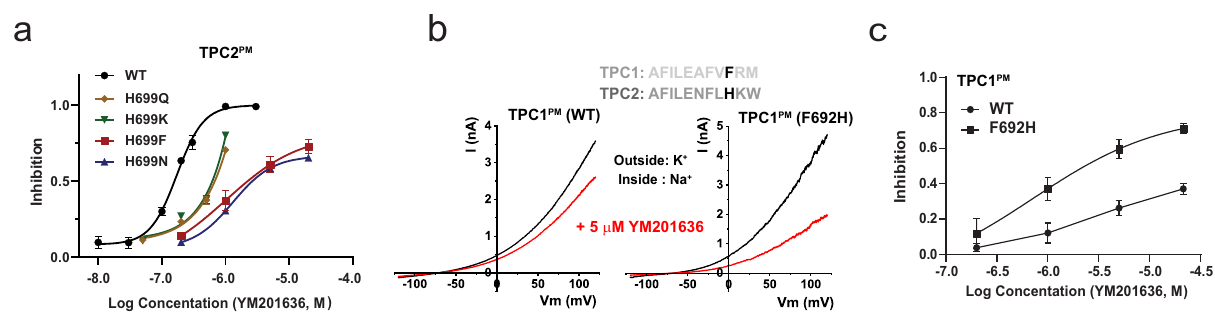
Fig. 5 The residue H699 underlies the increased sensitivity of TPC2 to YM201636 than TPC1. a The effect of mutations at H699 on the dose-responses ( n = 5 – 7 for each data point) of the YM201636 ’ s inhibition of the TPC2 PM channel. b The effect of YM201636 on WT and mutant H692F of human TPC1 PM channel. The sequence alignment of human TPC1 and TPC2 at the mutated region was showed on top. Phe692 in TPC1 and His699 in TPC2 channel were indicated in black. c Dose-responses ( n = 3 – 8 for each data point) of YM201636 ’ s inhibitory effect on WT and H692F mutant channels of human TPC1 PM . All recordings were done in inside-out con fi guration using asymmetric Na + (outside)/K + (inside) ( a ) or Na + (inside)/K + (outside) ( b , c ) recording solutions. The averaged data are presented as mean value ±